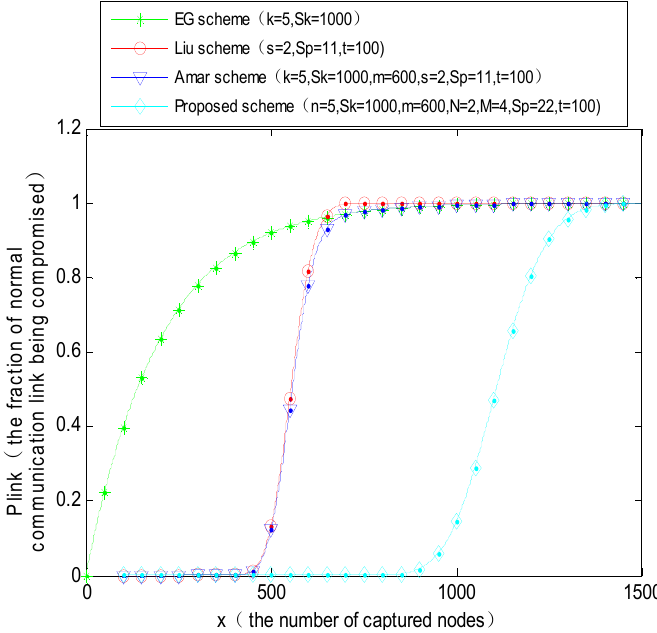
Figure 11. The probability that a normal communication link is captured when the direct connectivity p = 0.33.